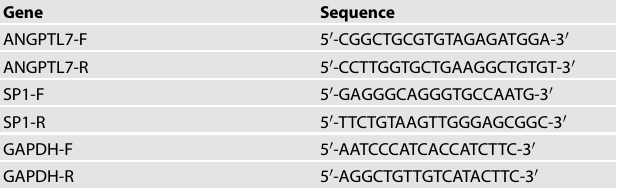
Table 2. Primers used in the qPCR